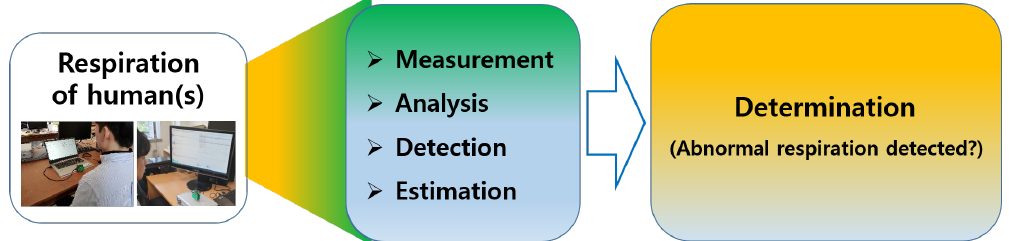
Figure 3. This paper’s goal was to provide a method to detect human respiratory status using a UWB radar